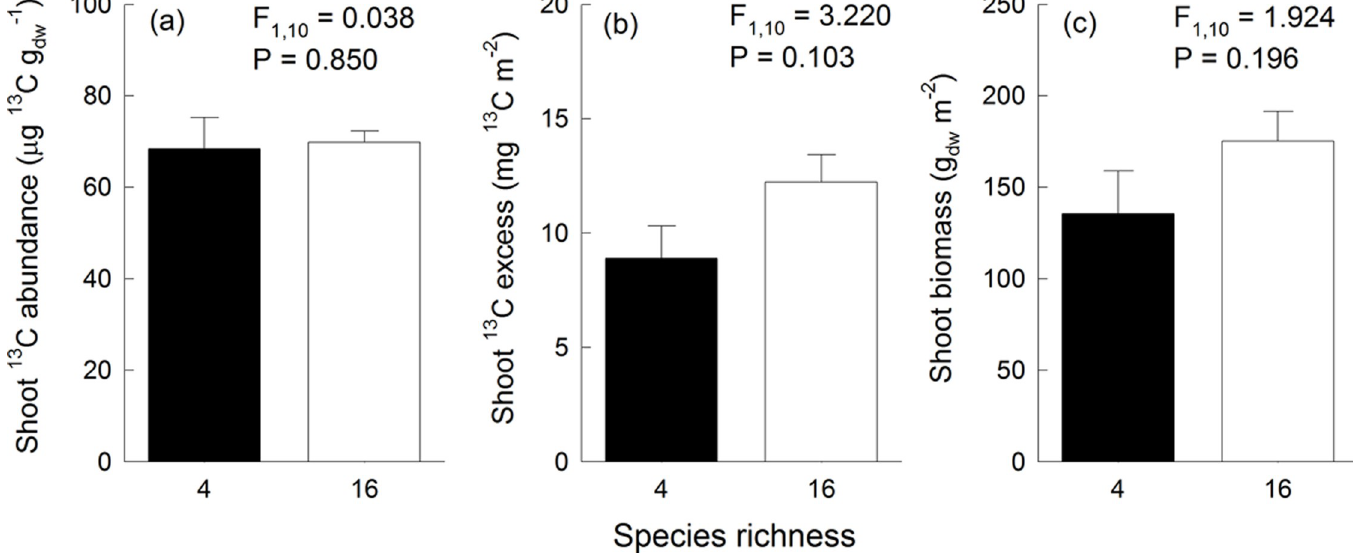
Fig 1. Community-level 13 C abundance, 13 C excess and biomass in relation to species richness. Relationships between species richness and community-level (a) 13 C abundance in shoot biomass, (b) shoot 13 C excess, and (c) shoot biomass. F statistics and P values were obtained from ANOVA testing for differences between diversity-